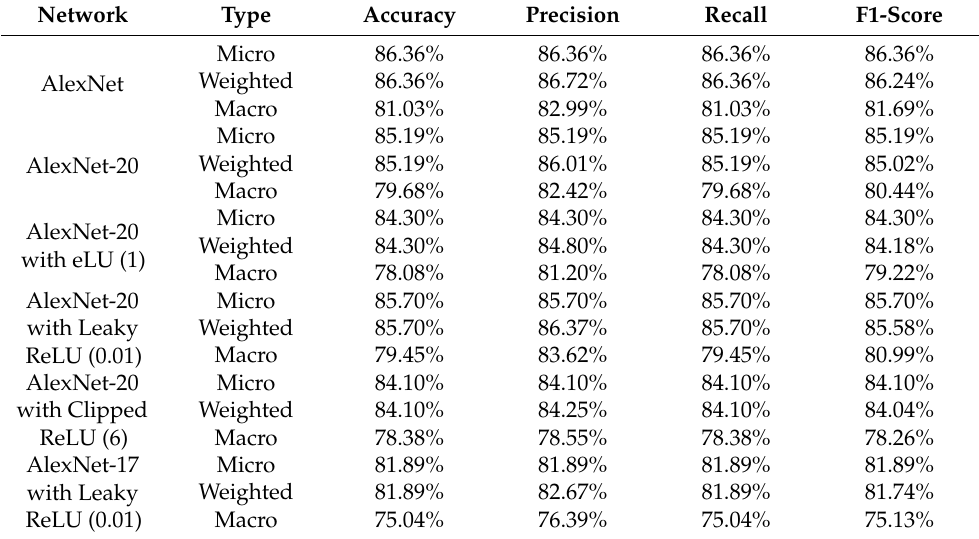
Table 5. Performance Measures of Different Networks using Variations of the